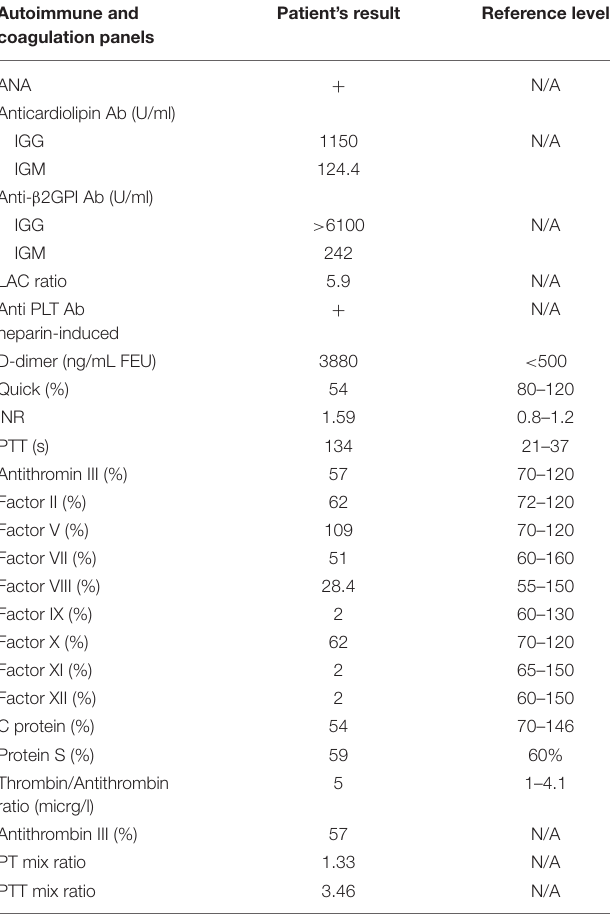
Patient’s result Reference